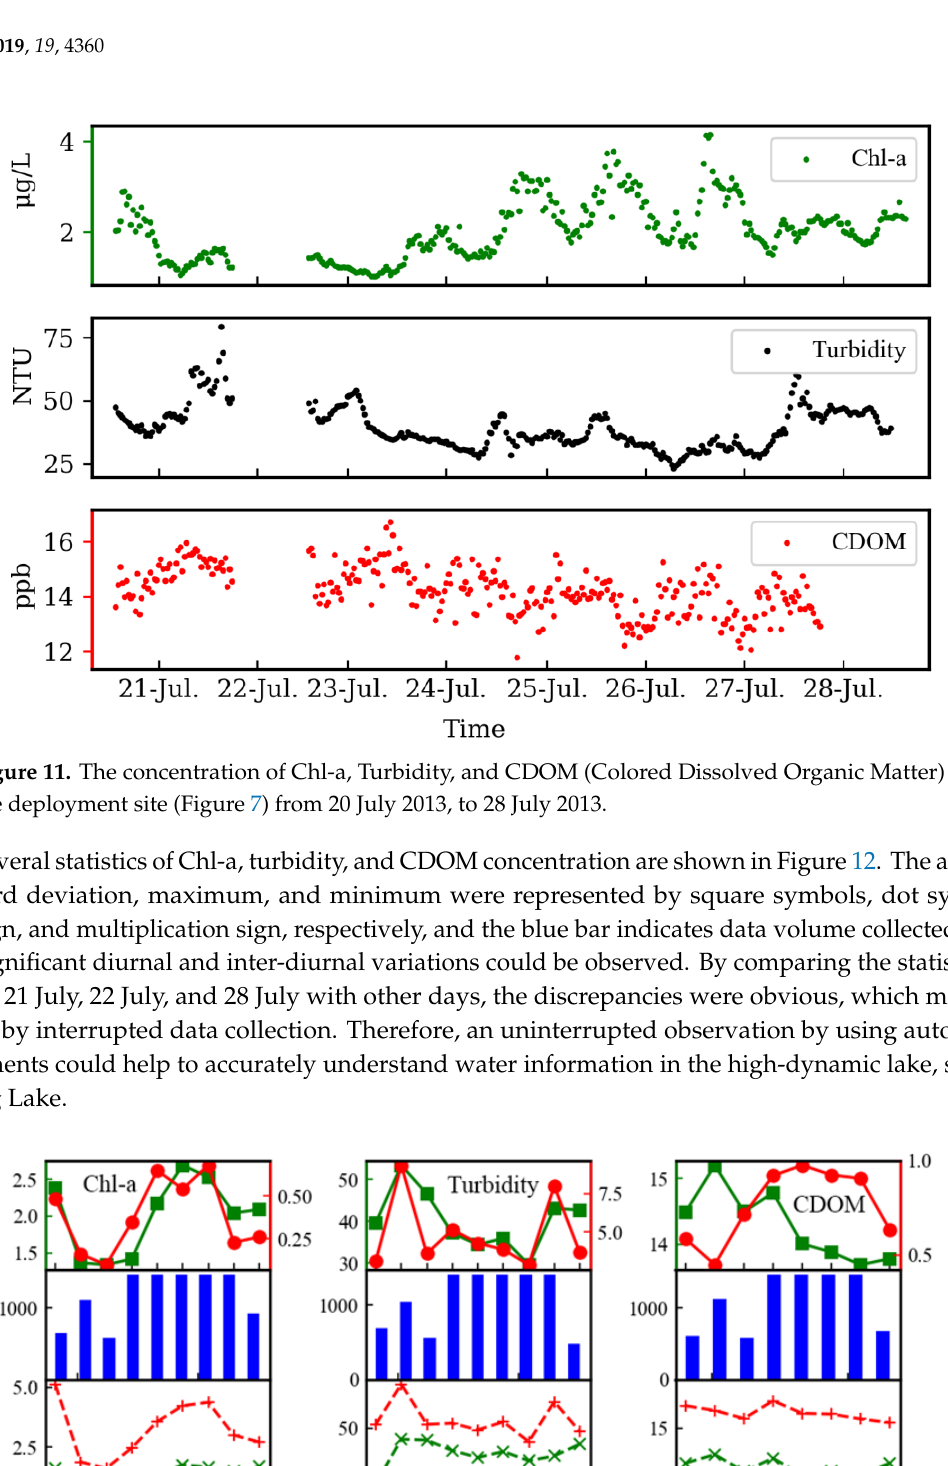
(8) Figure 13. Regression model of water quality parameters with the ratio of simulated Landsat 8 OLI (Operational Land Imager) remote sensing reflectance. ( a ): Chl-a, ( b ) turbidity, ( c ) CDOM. Significant relationships between Chl-a and turbidity and specific band ratios were observed with the determining coefficients of 0.59 and 0.74, and the root mean squared errors of 0.44 μg/L and